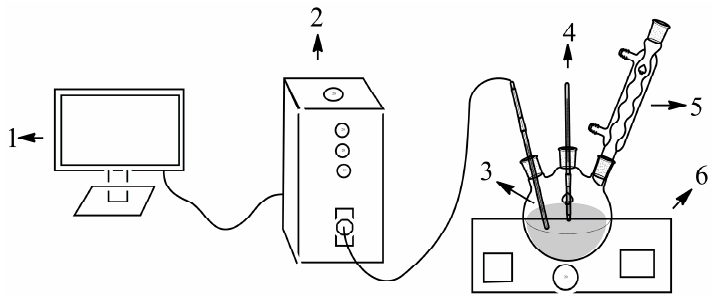
Figure 7. Diagram of the experiment setup; 1. Data analysis of computer; 2. ReactIR15; 3. Dector part; 4. Electric mixer; 5. Reflux condensation; 6. Oil bath pot.